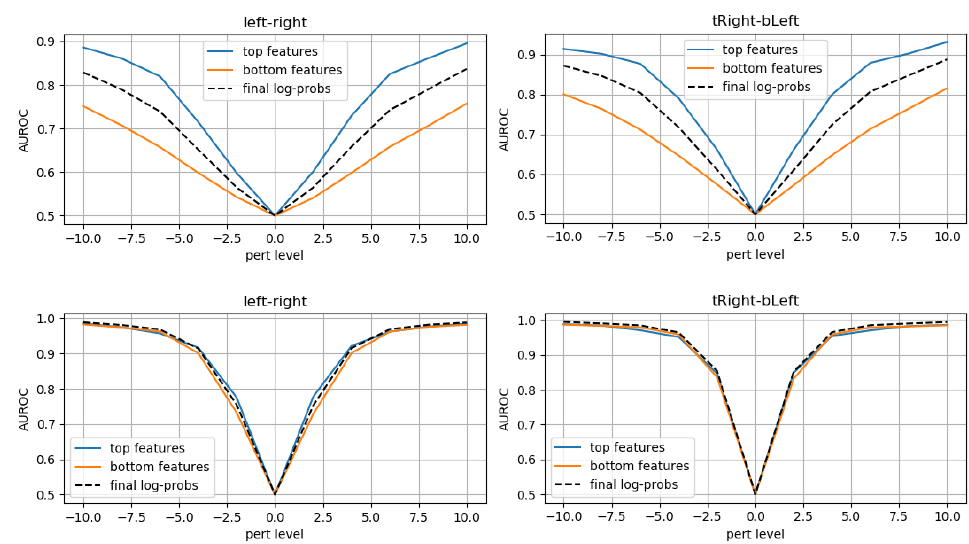
Figure 15. Baseline model ( first row ) compared to proposed network ( last row ): AuRoC values for separating OoD mask-translated samples, using either top-features or bottom-features. Dashed black lines represent default model performance using regular log-probs.